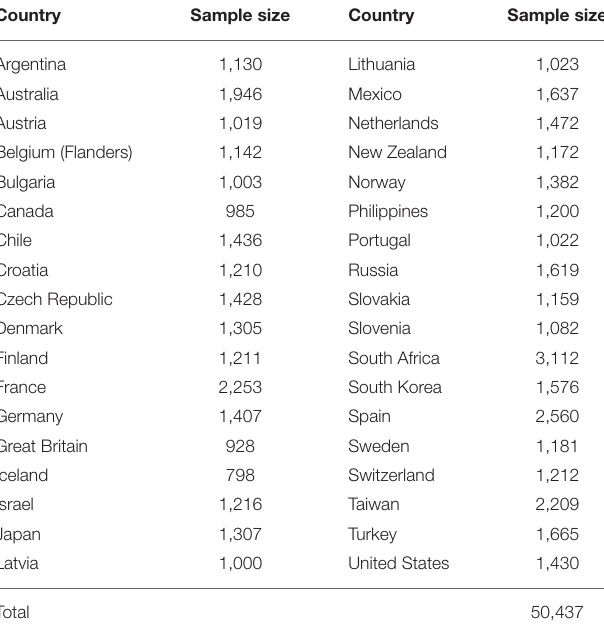
TABLE 2 | Participating countries in the ISSP environmental